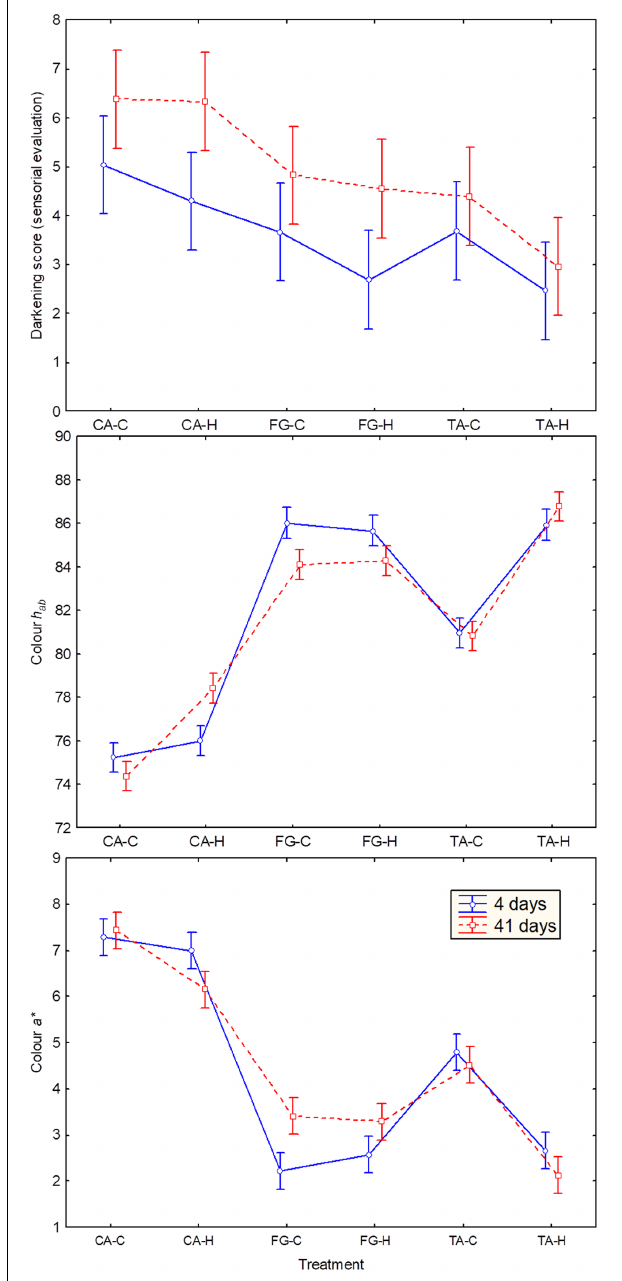
FIGURE 6 | Darkening score assigned by panelist (upper) , hue angle ( h ab , middle ), and greenness ( a ∗ , lower ) concerning the diverse treatments. Error bars for instrumental measurements denote standard deviation calculated from duplicate packaging. CA-C, cured control; CA-H, heat-shocked cured olives; FG-C, refrigerated fresh green control; FG-H, heat-shocked refrigerated fresh green olives; TA-C, control of traditional olives; and TA-H,